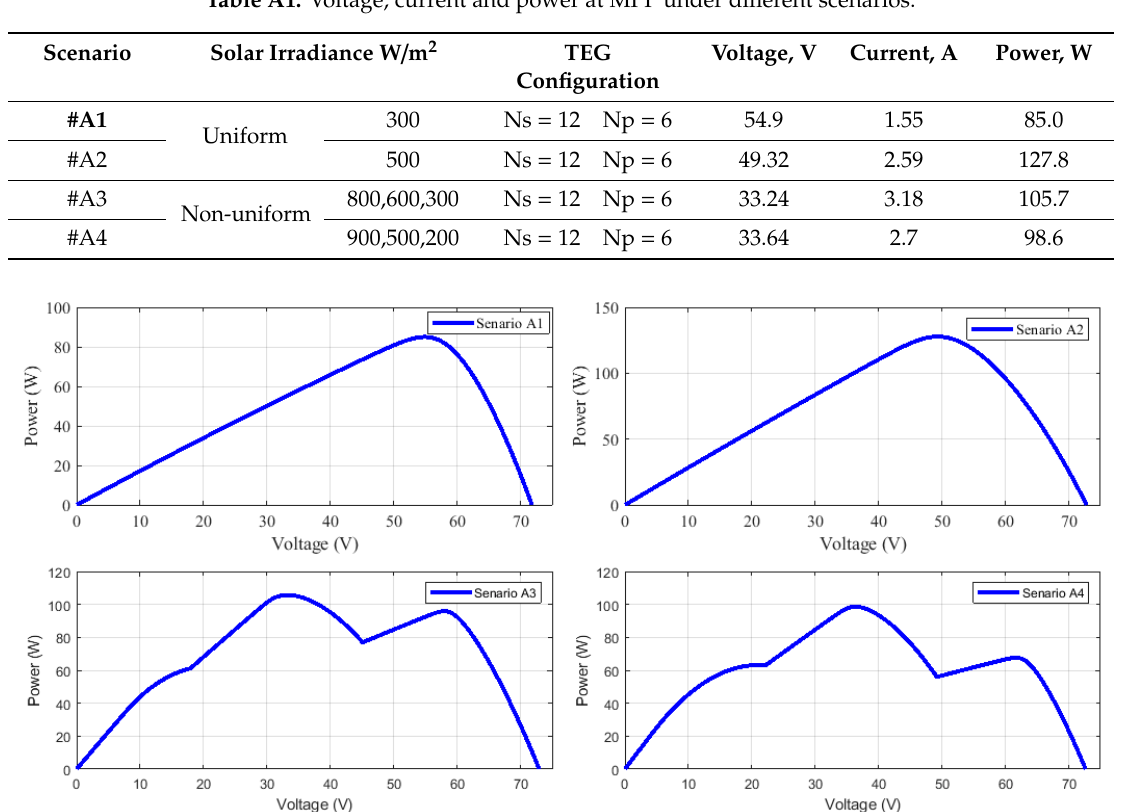
Figure A1. Power against voltage curves under different scenarios.